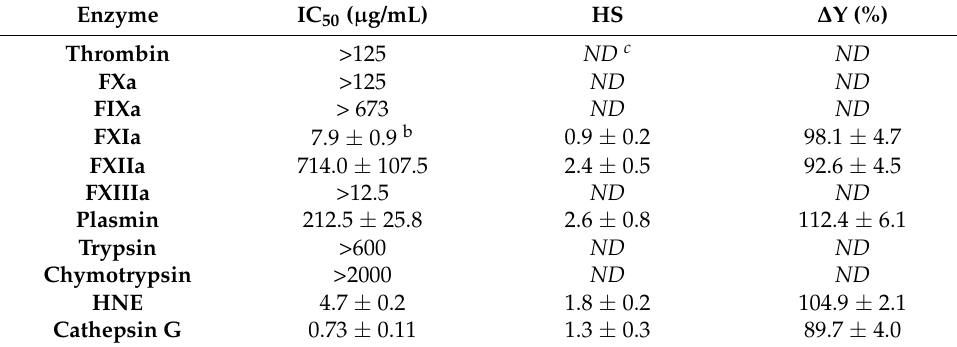
Table 2. Inhibition of clotting factors by LSAS a